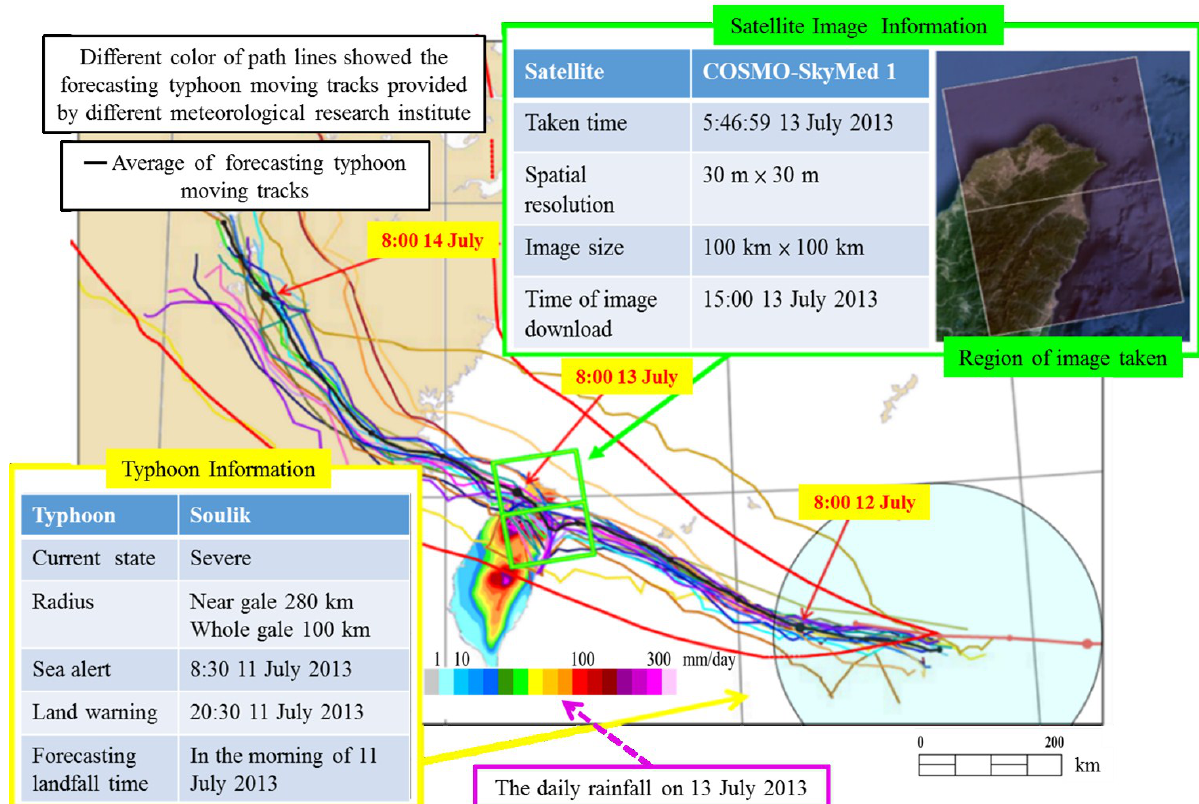
Figure 1. Information about Typhoon Soulik and its moving tracks forecasted at 20:00, 11 July. Two COSMO-SkyMed 1 radar satellite images with a spatial resolution of 30 m and a 100 × 100 km 2 coverage area were scheduled at 5:46:59, 13 July [26]. The region of the image taken is shown by the green box. The different colors of the path lines show